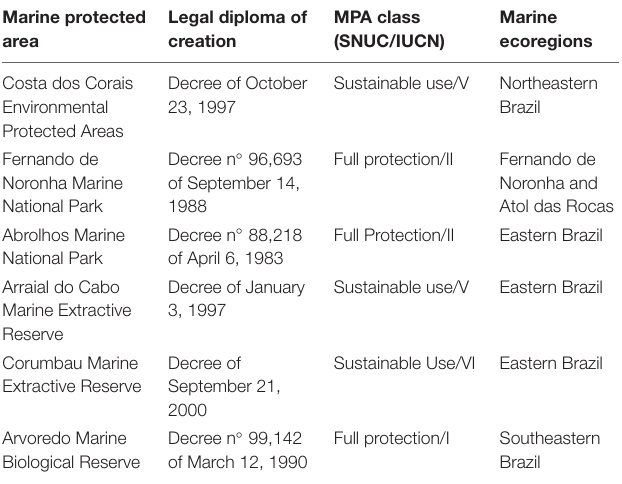
TABLE 1 | Marine protected areas in which the study was developed, comprising the marine ecoregions of Fernando de Noronha and Atol das Rocas, northeastern Brazil, eastern Brazil, and southeastern Brazil.